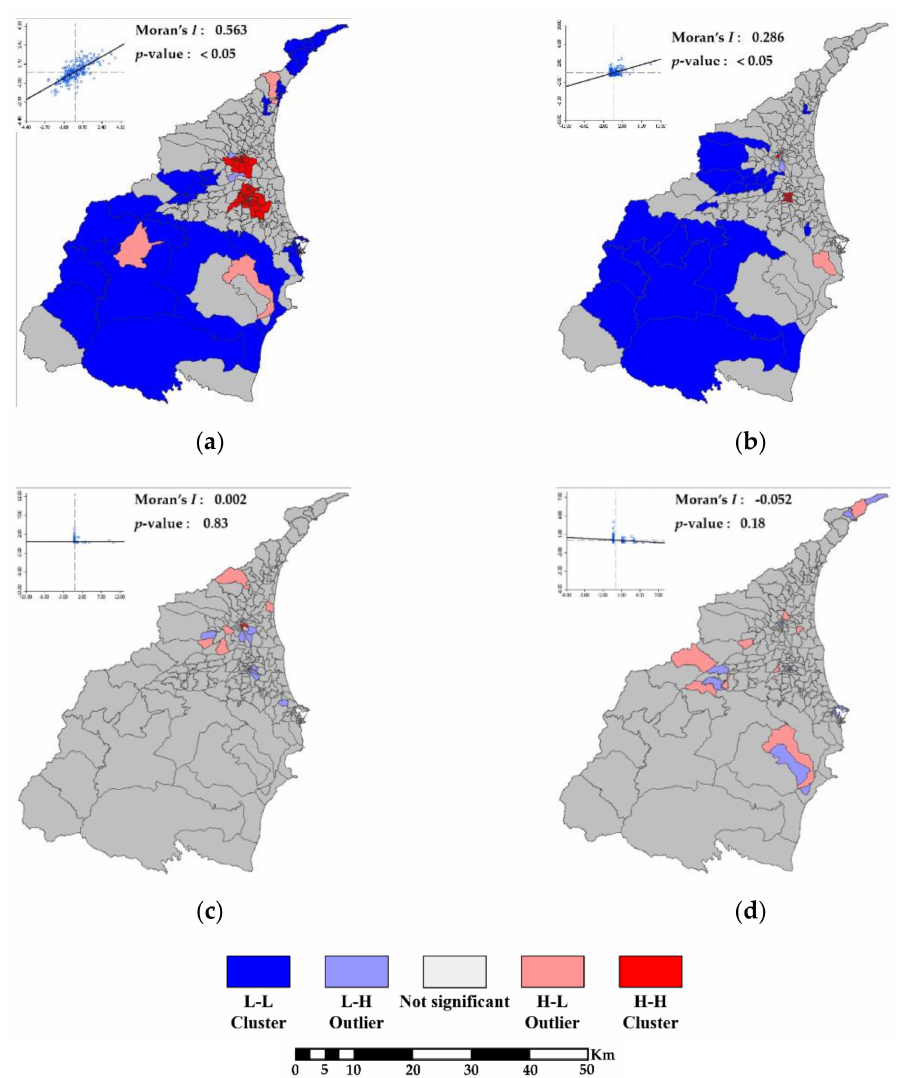
Figure 4. Spatial pattern of principal component in community-scale: ( a ) socioeconomic community; ( b ) fundamental medical; ( c ) institutional; ( d )